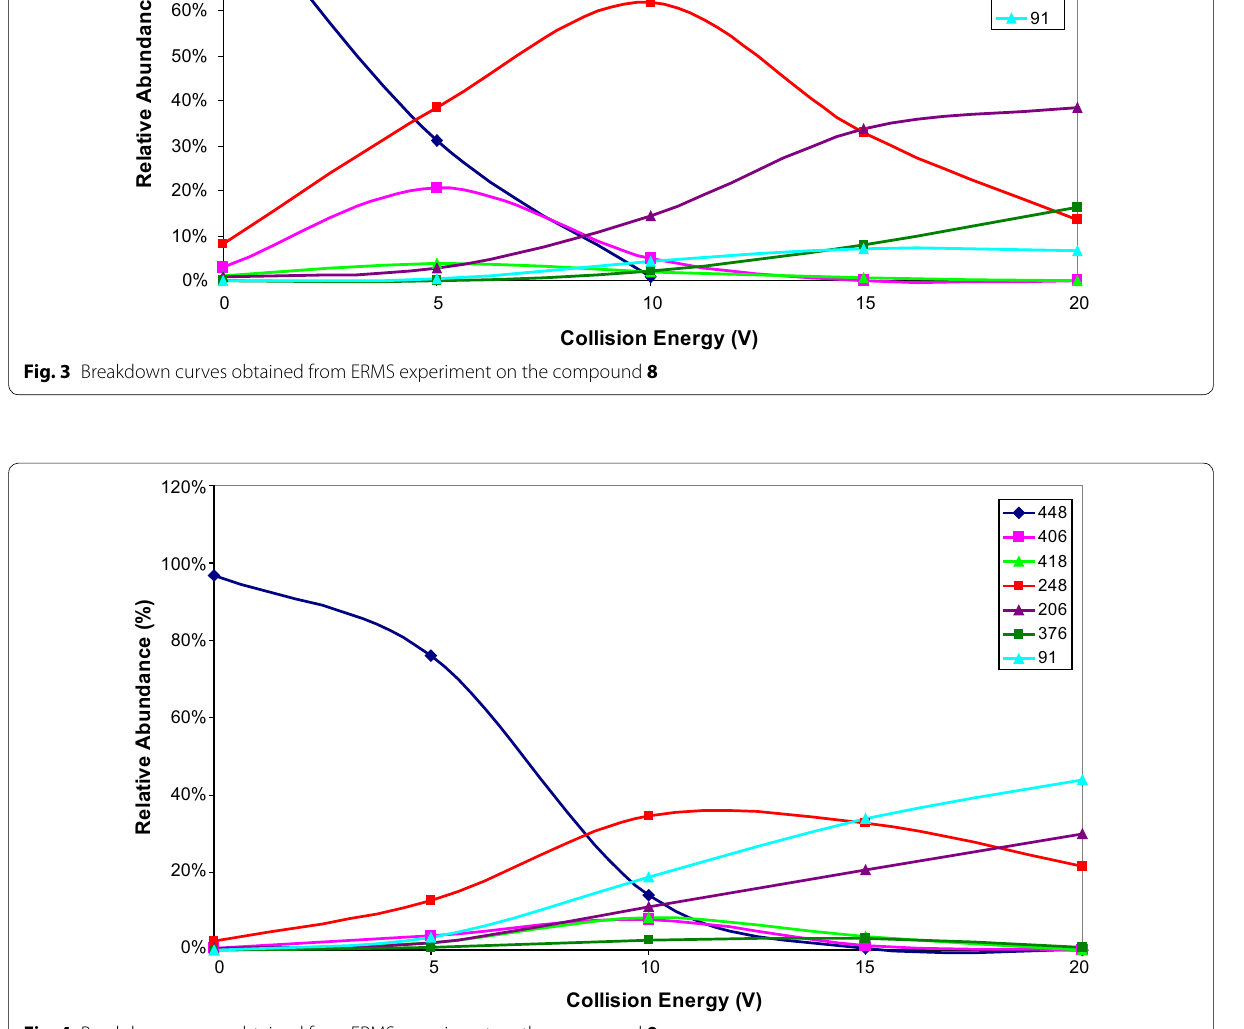
Fig. 4 Breakdown curves obtained from ERMS experiment on the compound